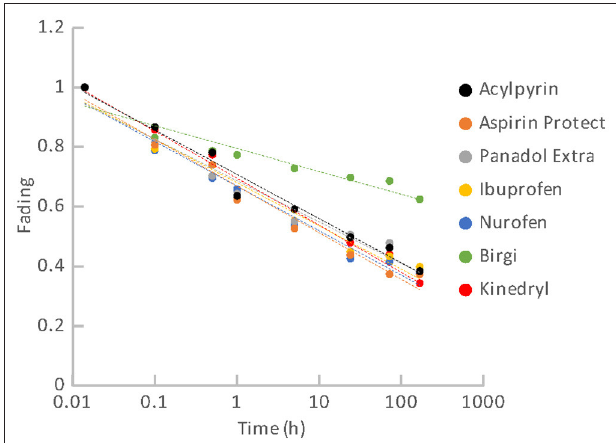
FIGURE 11 | Fading for the group of pharmaceuticals.